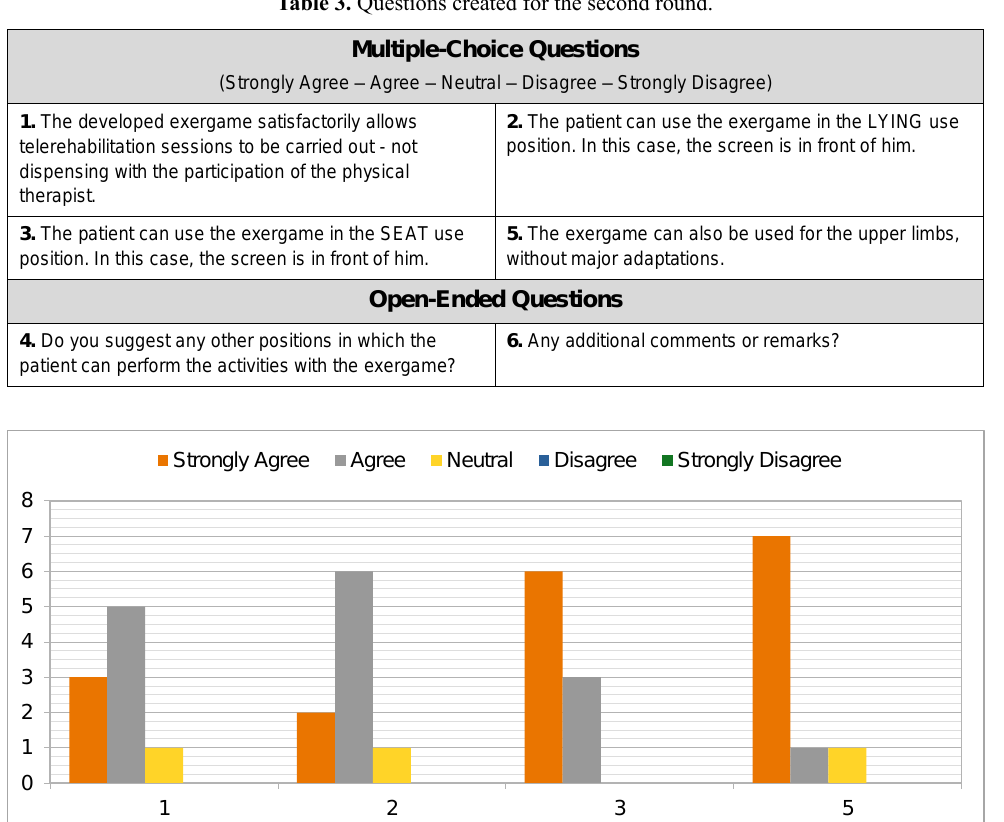
Figure 12. Distribution of answers to the second round multiple-choice